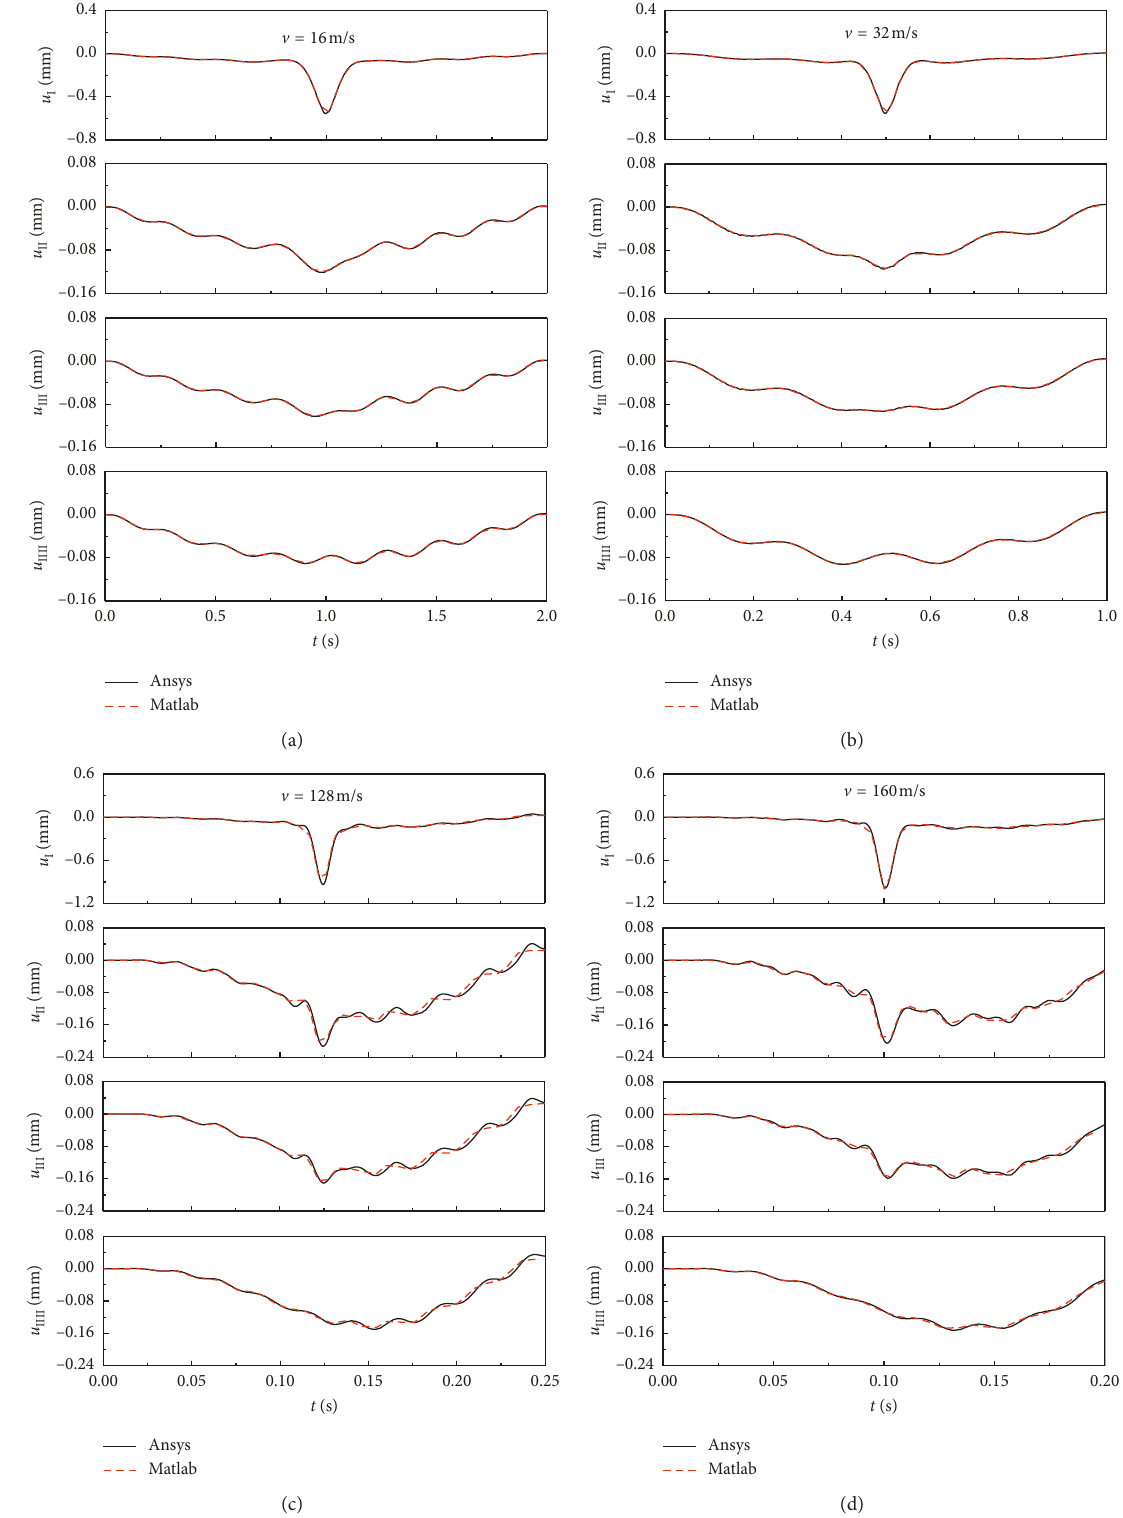
Figure 2: Comparison of dynamic response time-history curves of four-layer beam system under four moving